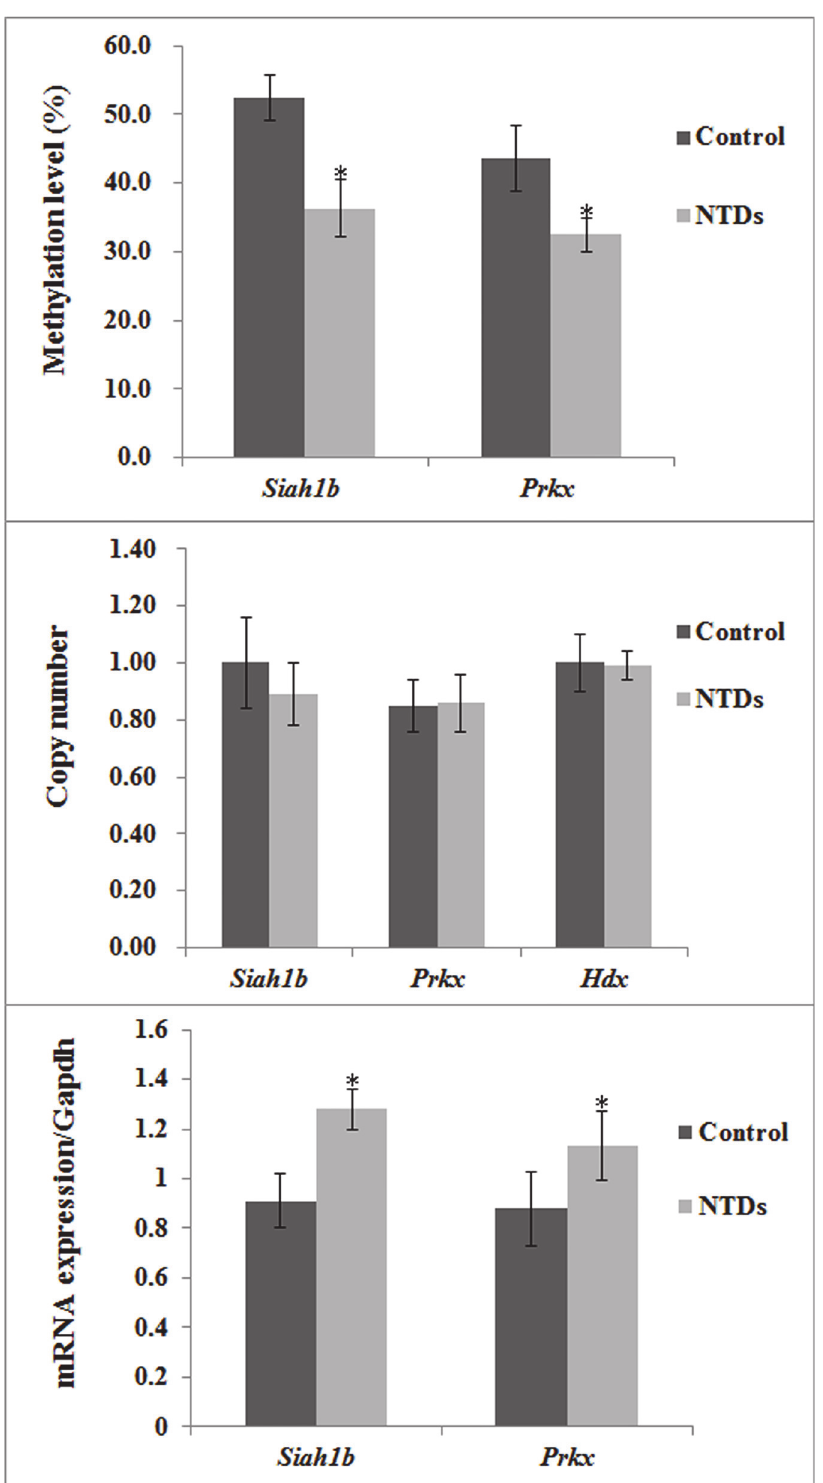
Fig 5. Confirmation of the differential methylation genes. A:Changes in DNA methylation levels in Siah1b (ChrX:160513241 – 160516941), Prkx (ChrX:75040559 – 75044259); B: Comparisons of the two genes expressions between NTDs and control samples; C: Comparisons of copy number varitions of the two genes between NTDs and control samples, * P < 0.05 NTDs versus control.